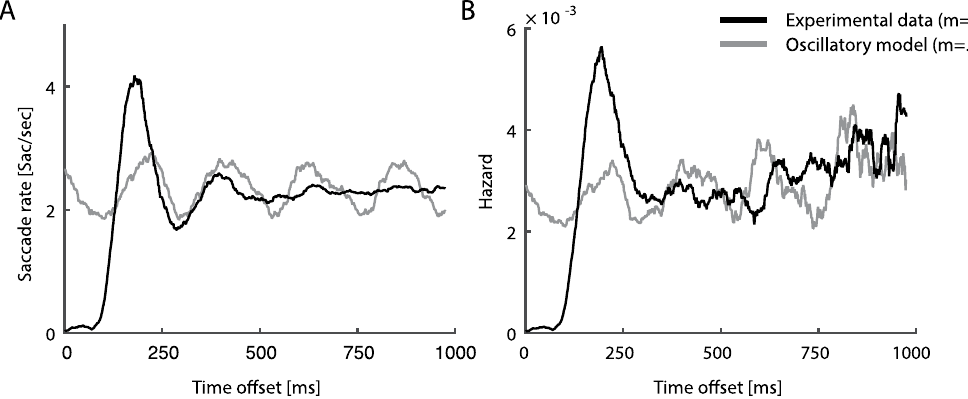
Figure 4. Comparison of saccade data and an oscillatory simulation model. ( A ) Autocorrelation function of subject 3 who participated in Exp. 2, normalized to represent post-saccadic saccade rate in Hz (black). The autocorrelation function of an oscillatory model matched in modulation index (gray). ( B ) Hazard function of the same data-set (black) and of its matched oscillatory model